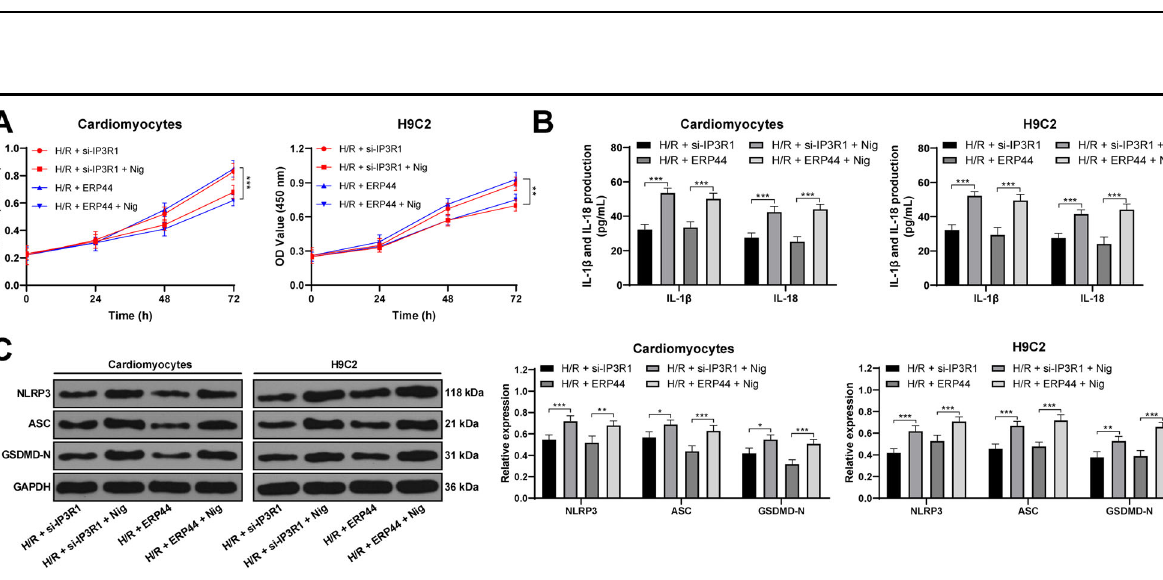
Fig. 6 Activation of NLRP3 pathway reverses the protection of ERP 44 against H/R injury. A CCK-8 was used to detect cell viability; B ELISA was used to detect the levels of IL-1 β and IL-18 in cells; C western blot was used to detect the levels of pyroptosis markers in cells. Nig represents an activator of NLRP3. * p < 0.05, ** p < 0.01, *** p < 0.001. All experiments were performed three times independently. Data were analyzed using two-way ANOVA and Tukey ’ s multiple comparison